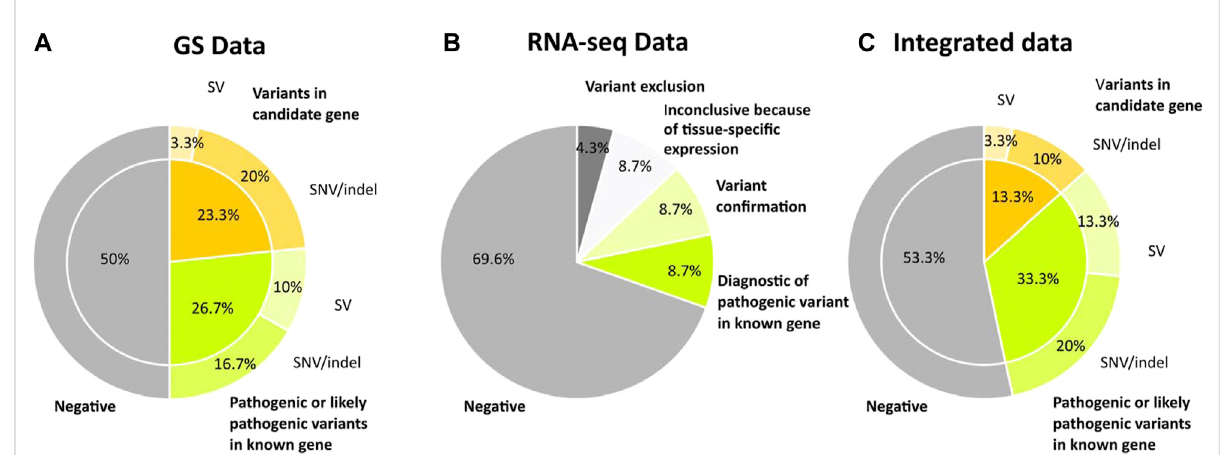
FIGURE 2 Diagnostic yield obtained with the different approaches deployed. Schematic representation of the evolution of the diagnostic yield in our cohort of 30 individuals with heterogeneous rare neurodevelopmental disorders. (A) The initial diagnostic yield with the genome sequencing (GS) data alone. (B) Contribution of RNA sequencing (RNA-seq) to the diagnostic rate in 23/30 patients. (C) Diagnostic yield obtained by integrating GS, RNA-seq and DNA methylation results. GS, genome sequencing; RNA seq, RNA sequencing; SV, structural variant; SNP, single nucleotide variants; indel, insertion